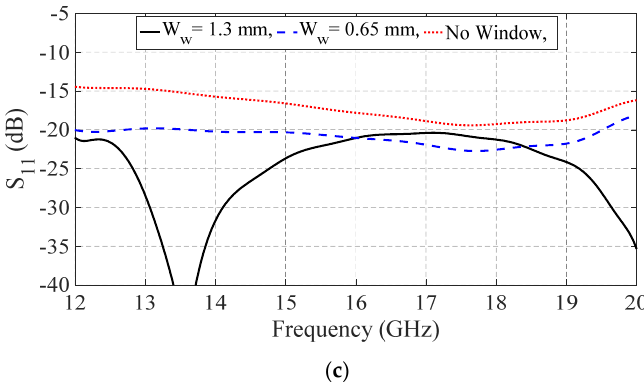
Figure 3. Simulated S-parameters of the transition by sweeping the design parameters: ( a ) step height, ( b ) pin height, and ( c ) window width.